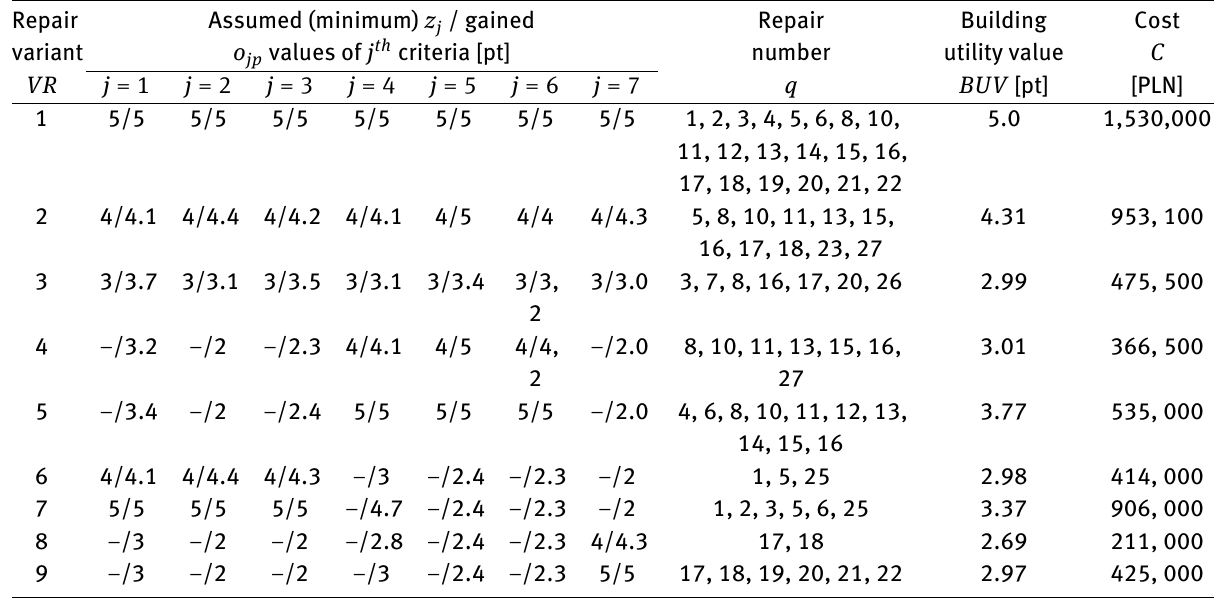
Table 7: Repairs and the cost of their execution for the assumed criteria values. Repair Assumed (minimum) z j / gained Repair Building Cost